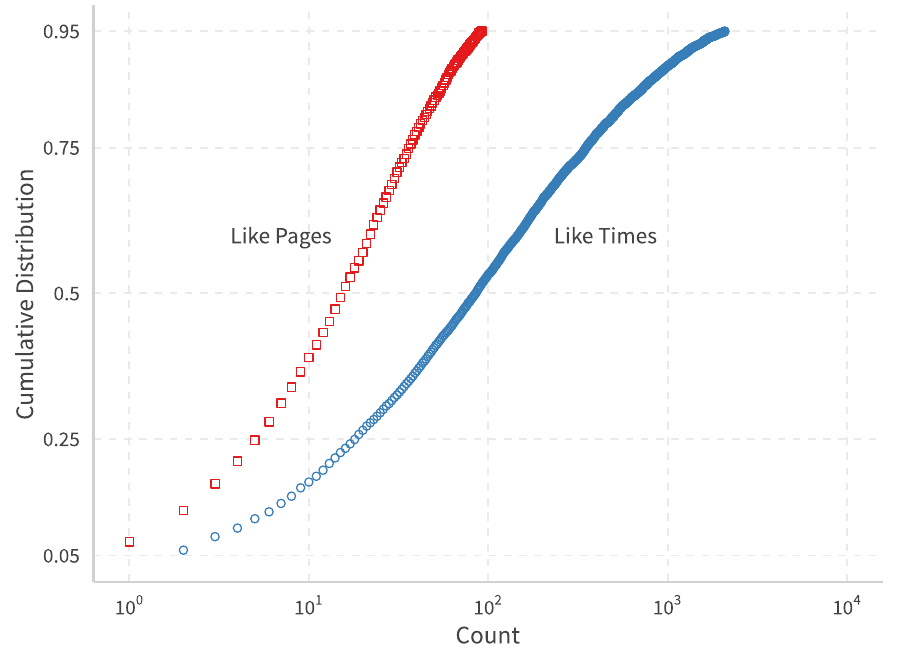
Fig 1. Distribution of pages and post per user likes. x-axis is log scaled.